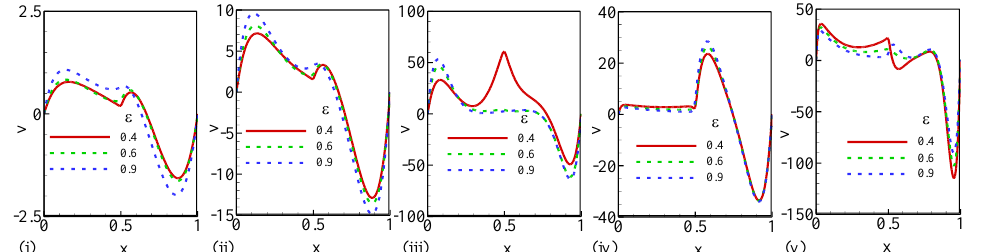
Fig. 7 (b). Effect of porosity parameters on normalized v velocity of vertical porous layer at (i) Ra =10 3 , 𝐷𝑎 = 10 −2 , (ii) Ra =10 4 , Da =10 -2 . (iii) Ra =10 5 , Da =10 -2 , (iv) Ra =10 5 , Da =10 -4 and (v) Ra =10 6 , Da =10 -4